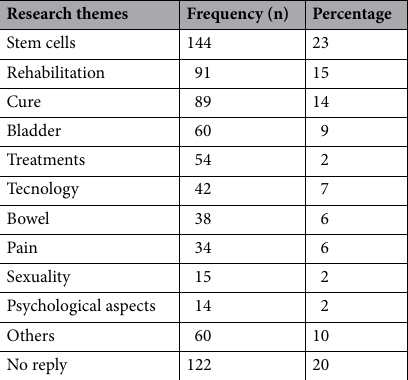
Table 1. Sample distribution according to the main research themes highlighted by the participants (n = 496), Brazil, 2018.